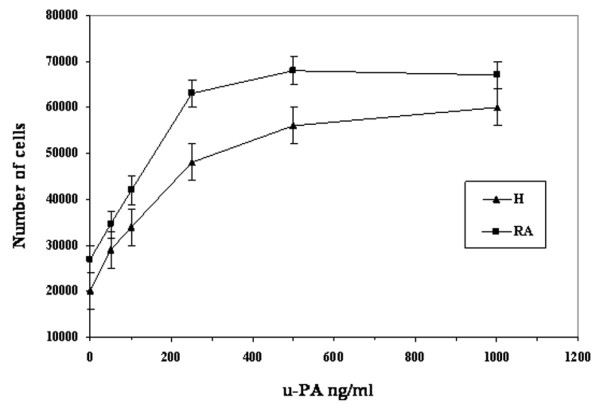
Urokinase-type plasminogen activator u-PA/u-PA receptor-dependent proliferation in healthy (H) and rheumatoid arthritis (RA) synoviocytes. Synoviocytes were seeded in 24 multi-well plates (15,000 cells/well) with 10% FCS in RPMI 1640. After 48 h incubation, cells were washed three times with serum-free medium and incubated in 0.2% FCS medium for an additional 48 h. At this time, cells were incubated for 48 h in 0.2% FCS containing increasing concentrations of u-PA (50 to 1,000 ng/ml). Proliferation of H and RA synoviocytes is reported as a function of u-PA concentration. Each point represents the mean ± standard deviation of three experiments performed in triplicate on four normal and four RA synovial cell lines.